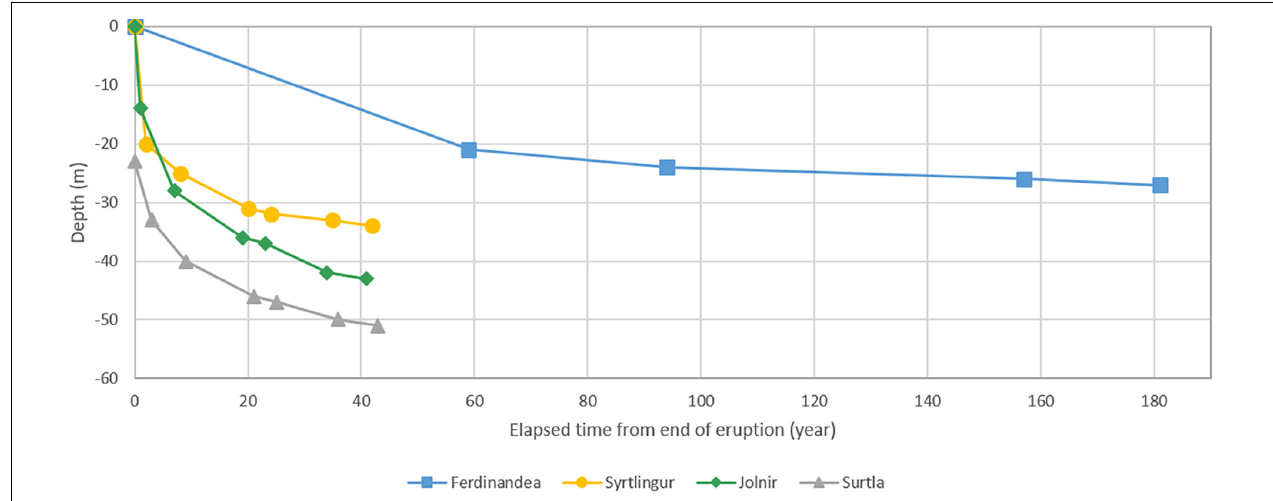
FIGURE 10 | Graph of depth with time of the average depth of the flat summit of Surtla, Jólnir, and Syrtlingur until 2007 (Jakobsson et al., 2009) and Ferdinandea until 2012. The efficacy of wave-current erosion rapidly decreases with increasing